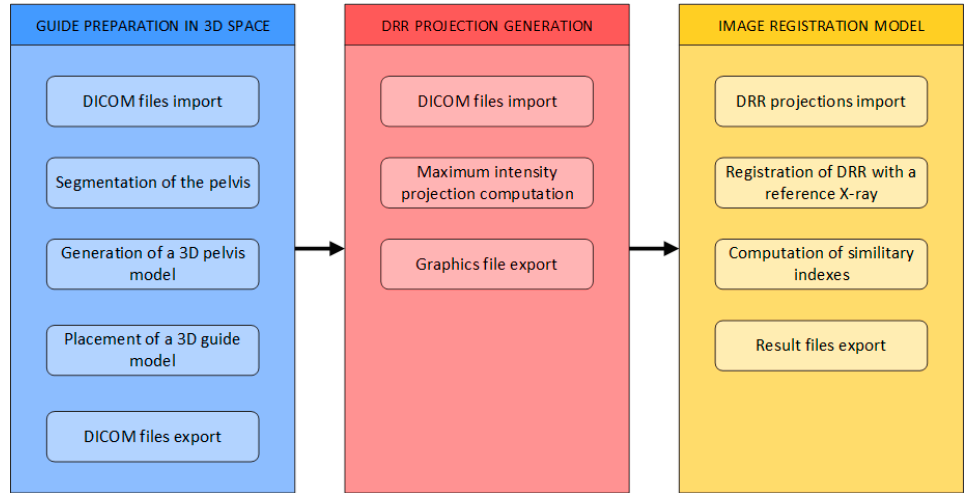
Figure 1. General workflow of 3D generation to image registration.